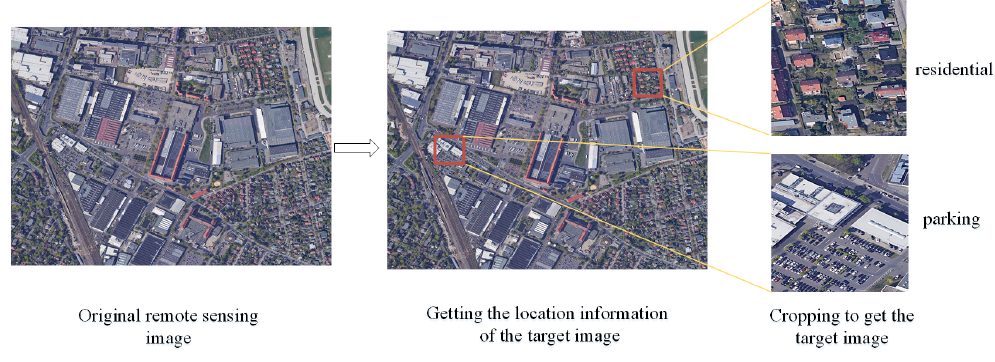
Figure 2. The construction process of remote sensing image scene classification database.